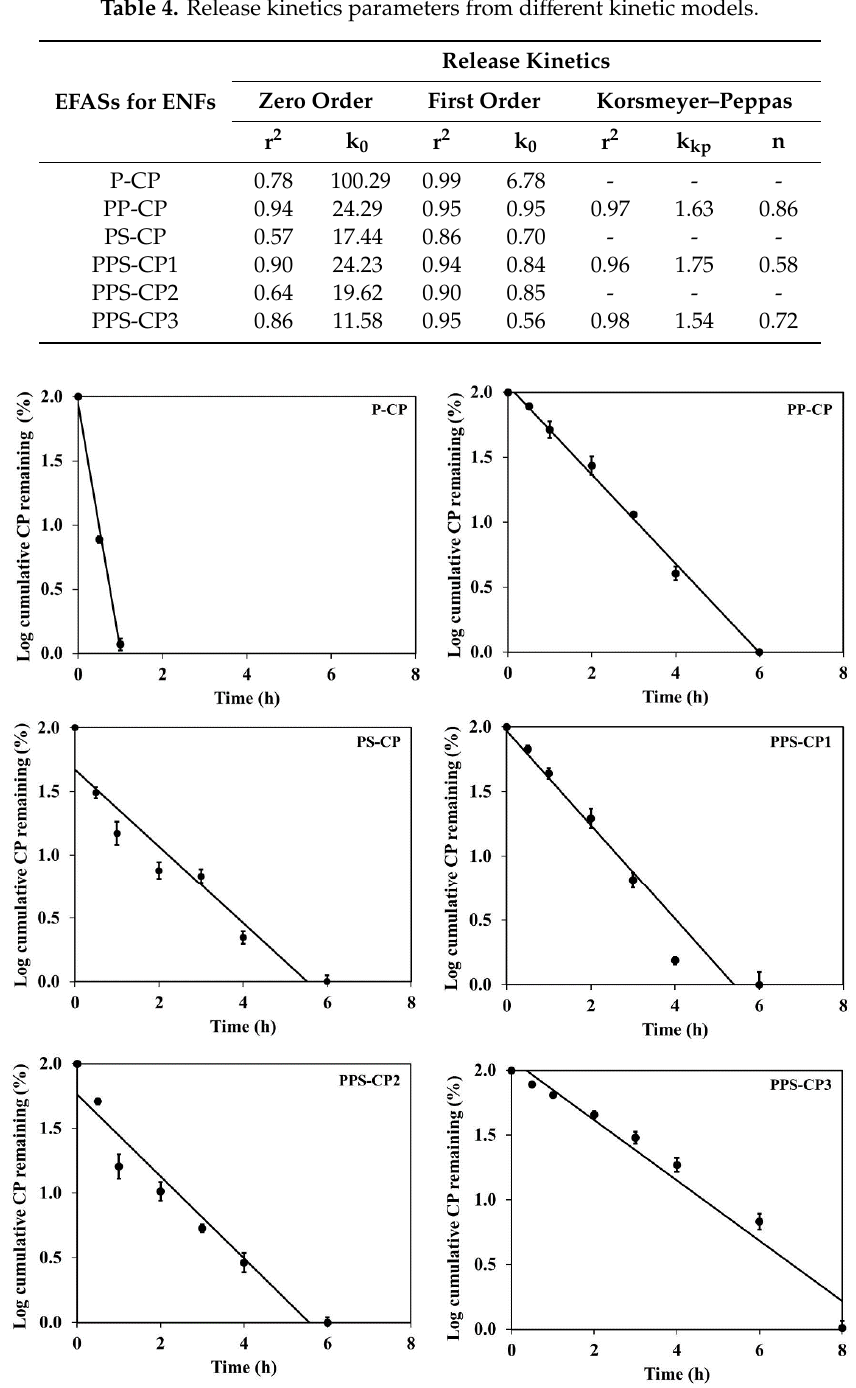
Figure 5. Kinetic plots of CP release according to the first-order kinetics.